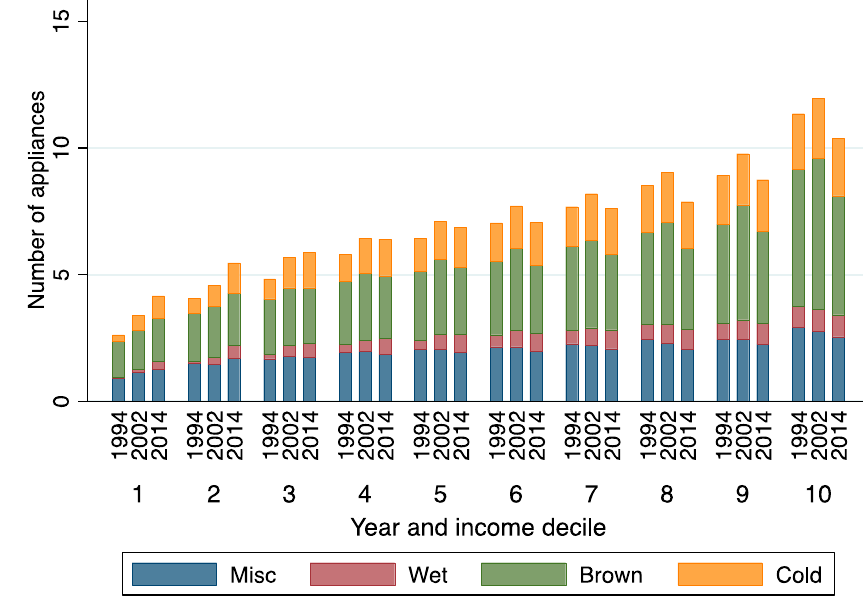
Figure 5. Number of appliances by income decile and end-uses. Mexico, 1992, 2002, and 2014. Source: Authors’ calculations, ENIGH